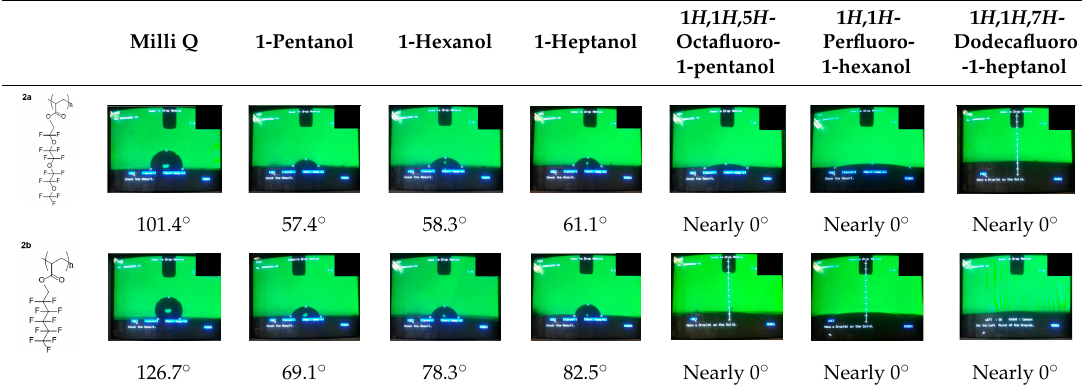
Table 2. The contact angles of fluoroethylene glycol polymer ( 2a ) and fluoroalkyl polymer ( 2b ) against different solvents.